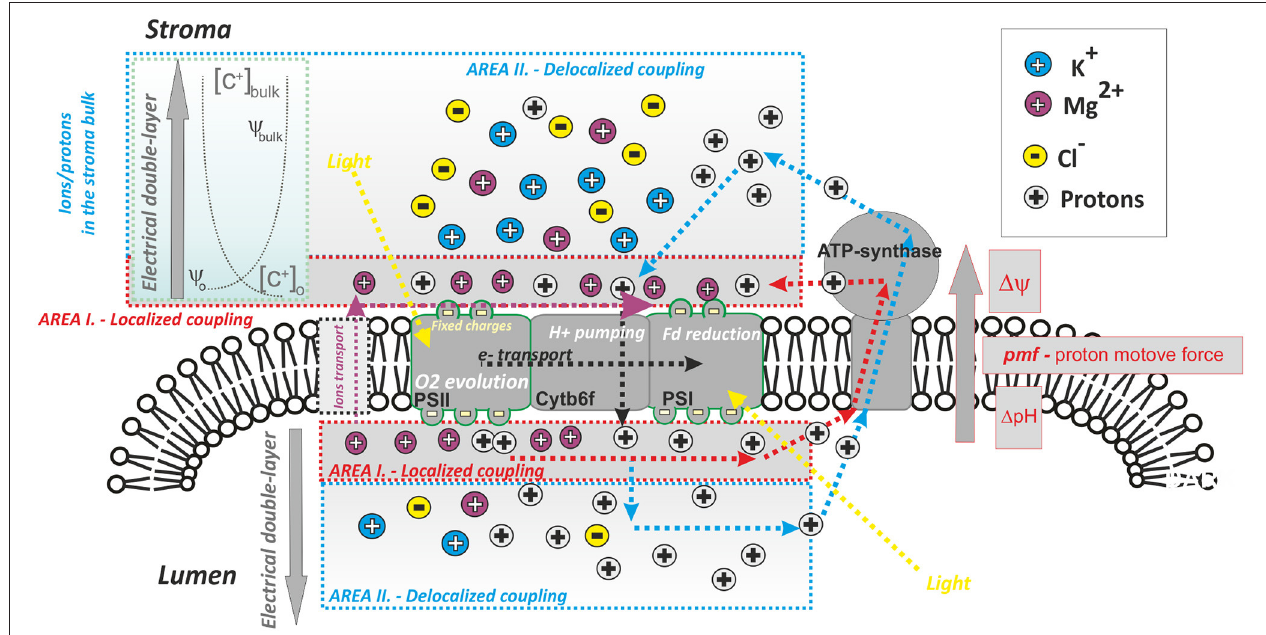
FIGURE 1 | A simplified scheme of photophosphorylation in photosynthesis: role of proton and ion heterogeneity. ATP synthase uses proton gradient across the thylakoid membrane; the proton transport across the thylakoid is coupled to light-driven electron transport (dotted black lines). The proton gradient forms electrochemical gradient of protons [ pmf —proton motive force, which includes 1 ψ (the membrane potential component) and 1 pH (proton gradient component; see Equation 1)]; pmf is the driving force for ATP synthesis. The most accepted view of photophosphorylation is: “delocalized phosphorylation”—equilibrated concentration of protons in the bulk (in the stroma/lumen) is used (original Mitchell theory—dashed blue lines, see Mitchell, 1966). A second less accepted view is that of “localized phosphorylation” (dashed red lines, see Mulkidjanian et al., 2006): protons from the local domains in lumen/stroma that are in the close vicinity of membrane (see Area I) are involved in ATP synthesis (Dilley, 2004). Localized protons interact with ions attached to fixed membrane charges, mostly Mg 2 + (note: K + and Cl − are more abundant in the thylakoid stroma/lumen bulk, see Barber, 1980b). The distribution of the dominant ions (K + , Mg 2 + , Cl − ) in the local (Area I) and bulk domain (Area II) areas is controlled by properties of the electrical double layer—EDL (see Cevc, 1990); EDL is characterized by the ion profile around the membrane, as well as the electrical field around the membrane, between ψ o and ψ bulk . (cf. Figure 2 ). Photosynthetic proton pumping into the lumen is accompanied by counter-ion transport from lumen into stroma. The process of electron transport and the use of protons by ATPase can be uncoupled by the addition of various ionophores (nigericin—electroneutral antiporter H + /K + ; valinomycin—K + ionophore; A23187—Mg 2 + ) that can disrupt the membrane potential and ion/proton gradients. The efficient activity of the particular ionophore in uncoupling requires the presence of appropriate cationic species at the membrane surface (Barber, 1980b); therefore, their uncoupling ability differs between high & low screening modes when more Mg 2 + and K + are attached to thylakoid membranes (see Figure 5